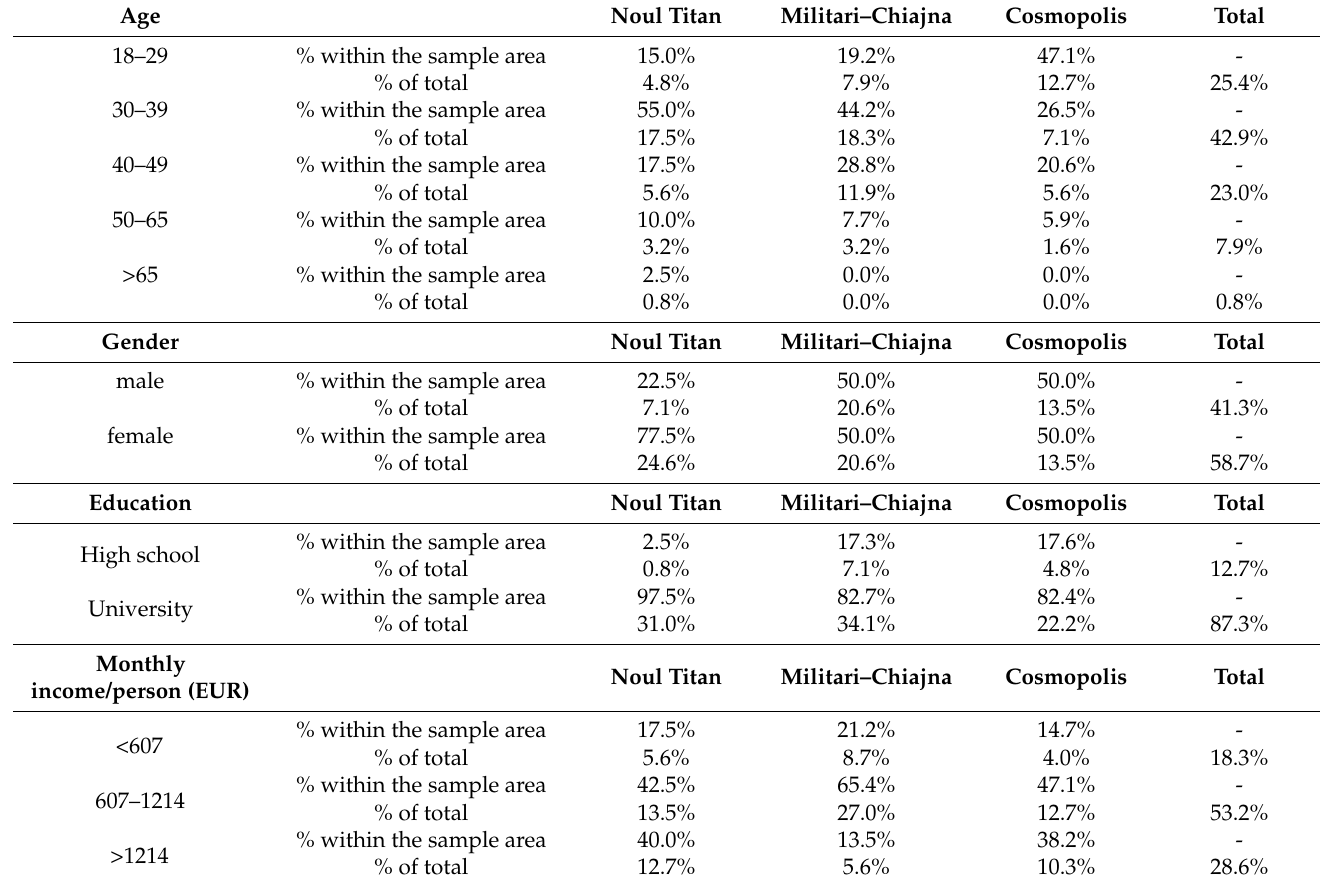
Table 1. Respondents’ sociodemographic profile in the three sample residential